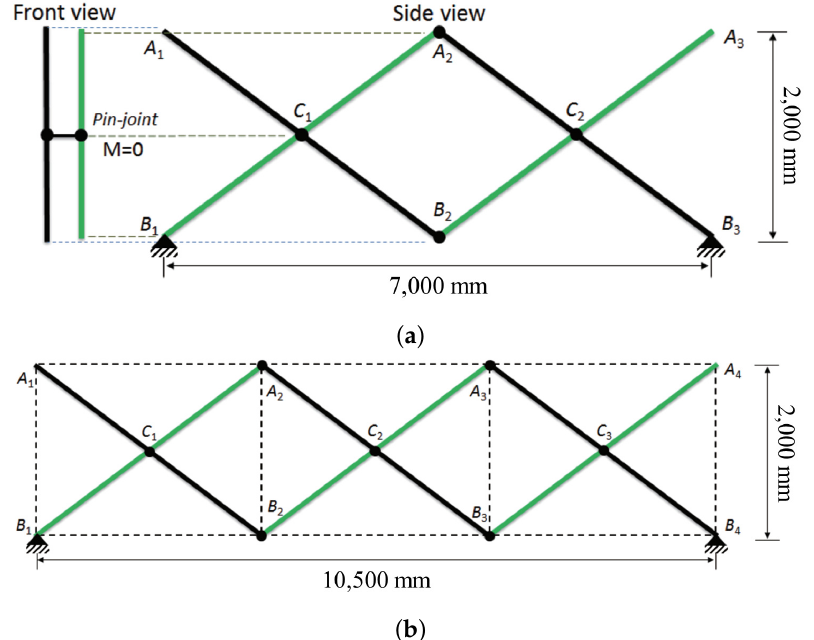
Figure 6. Outline of the FE numerical model based on full-scaled MB: ( a ) two scissors unit based on MB1.0; ( b ) three scissors unit based on MB1.1.